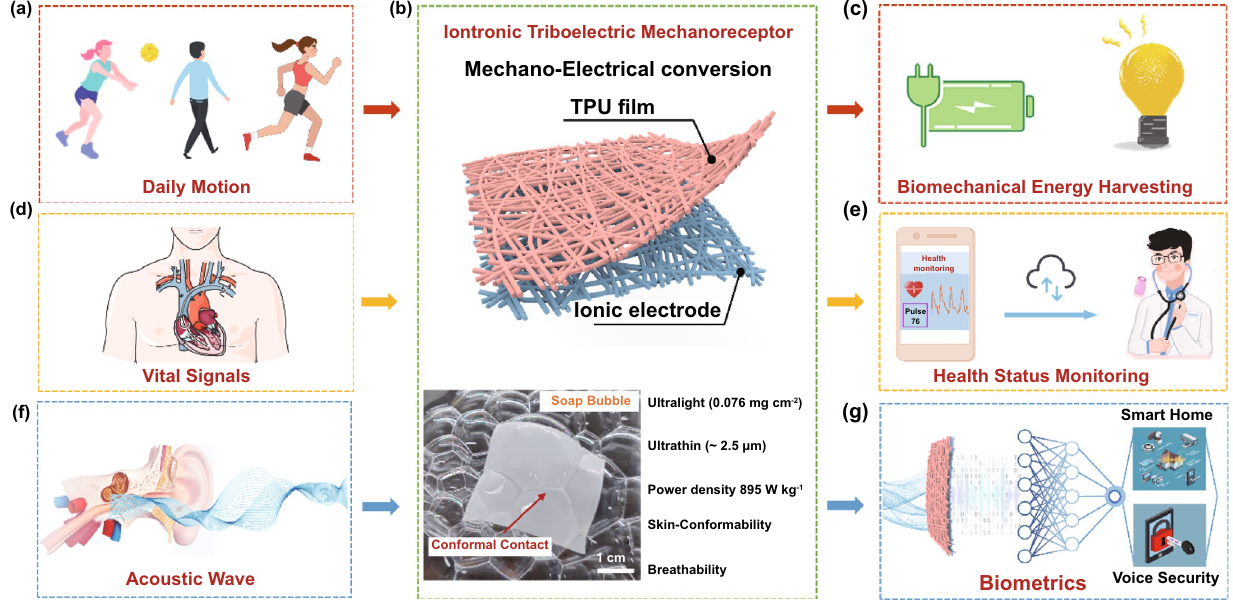
Fig. 1 Overall concept of ITM for multi-functional epidermal electronics enabled by mechano-electrical conversion. a , c Proposed images of the ITM for biomechanical energy harvesting; d , e the ITM is used for health status monitoring (cardiovascular monitoring) and the future vision for intelligent wearable health monitor; f , g highly sensitive frequency–response ITM mimicking the basilar membrane of human cochlea to achieve intelligent voice user interfaces through collaborating with machine learning algorithms; b basic structure scheme of the ITM (top); pho- tograph of the ultrathin and ultralight ITM floating on fragile bubbles